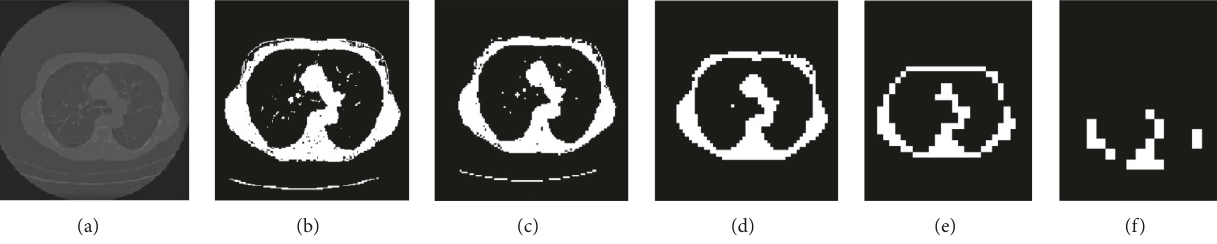
Figure 6: CT Scan image of a patient suffering from PSE and its different levels of 𝐿𝐿 images in wavelet transform (a) original image; (b) 1st level 𝐿𝐿 image; (c) 2nd level 𝐿𝐿 image; (d) 3rd level 𝐿𝐿 image; (e) 4th level 𝐿𝐿 image; (f) 5th level 𝐿𝐿